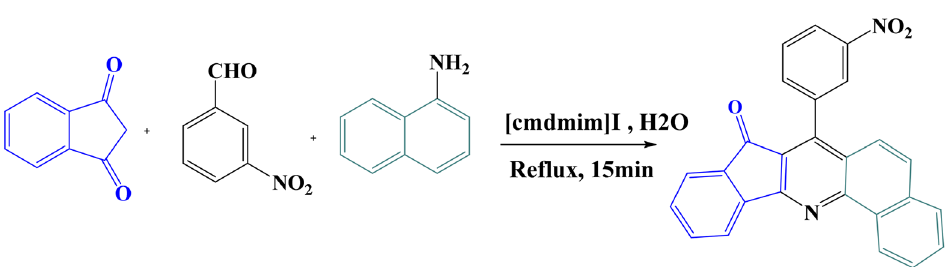
Scheme 1. The synthetic pathway toward synthesis of 4a compound in reflux